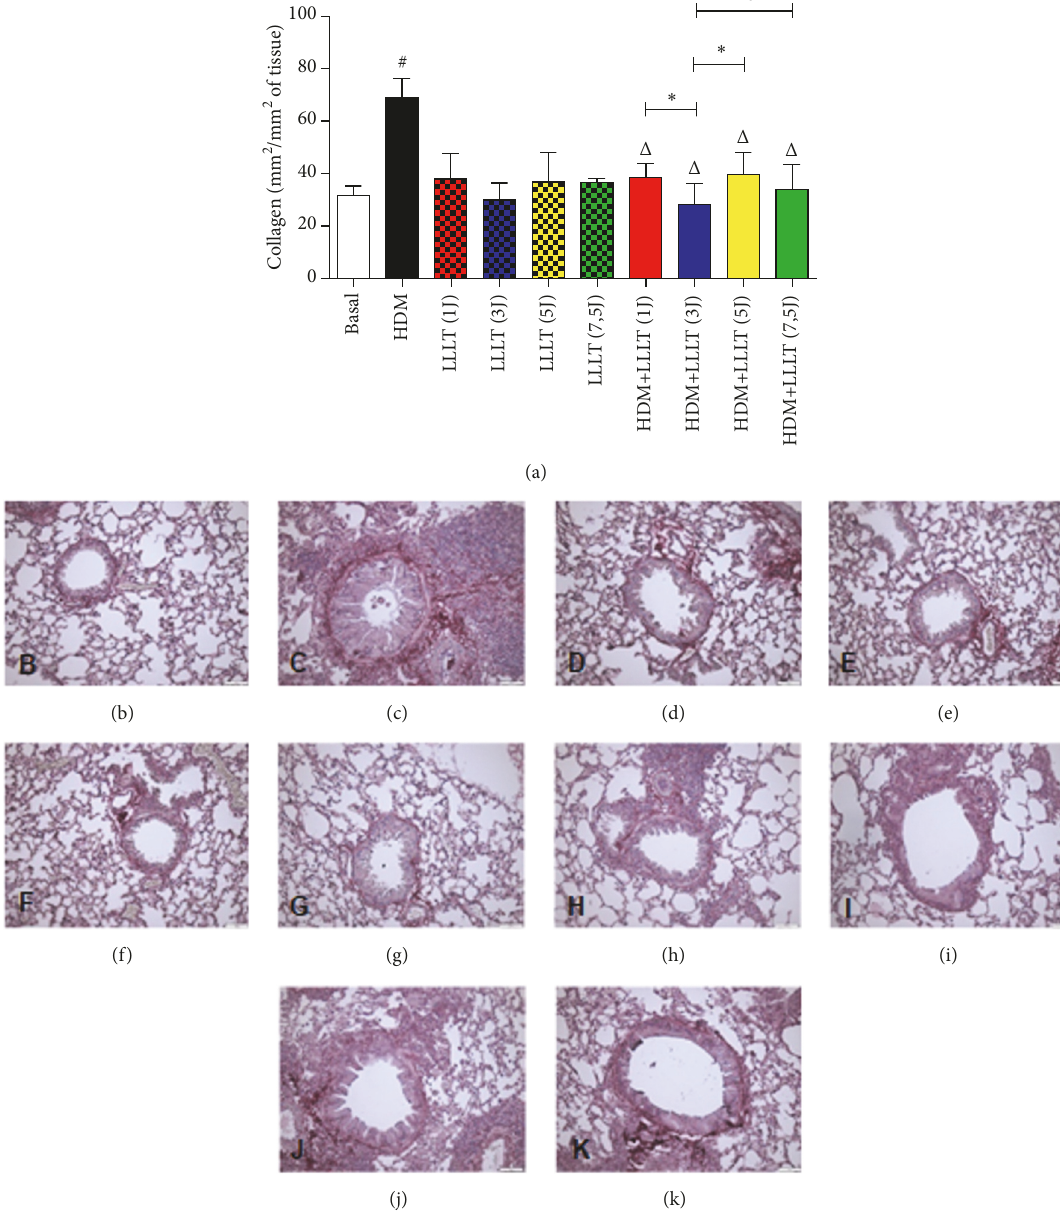
Figure 5: Effect of LLLT on the production of collagen in the airways. The lungs were fixed, prepared, and stained with PSR for analysis of collagen in the airways. The animals were irradiated with LLLT 3x/week for 5 weeks, 1 hour after challenge with HDM. Increase of × 200. Values expressed as mean and standard deviation. The groups used in the experiment are described in Figure 1. The results refer to the use of 10 mice in each experimental group. # p < 0.001 when compared to the Basal group and Δ p < 0.01 when compared to the asthmatic group (HDM) and ns (not significant) and ∗ p < 0,05 when compared HDM+LLLT (3J) group with the other groups treated with other